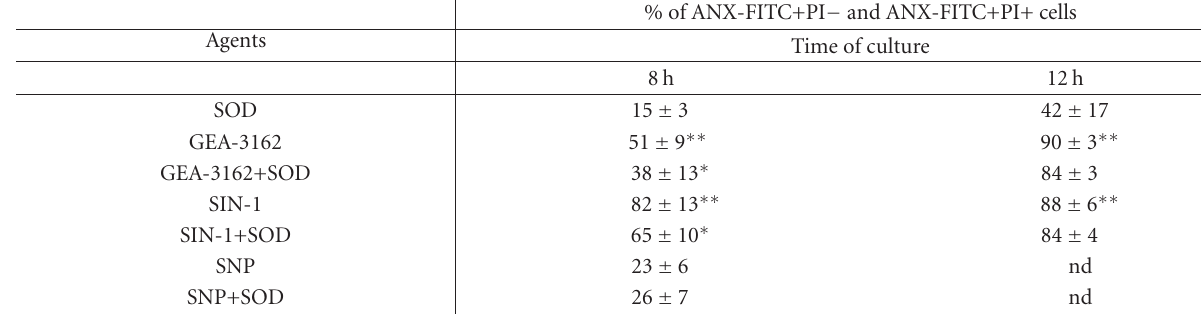
Table 1. Comparative analysis of apoptosis evaluated by ANX-FITC binding and cellular DNA content in the same sample of neu- trophil culture. Neutrophils (1 × 10 6 cells) were incubated with the indicated stimuli for 8 and 12 hours and apoptosis was determined as described in “materials and methods.” Results are given as means and SD percentages of apoptotic cells for 6 separate experiments. Statistical significance: neutrophils versus neutrophils with NO donors ( ∗ denotes that P ≤ . 05; ∗∗ denotes that P = . 027). % of ANX-FITC+PI − and ANX-FITC+PI+ cells % of cells with apoptotic nuclei Agents Time of neutrophils culture 8 h 12h Medium 28 ± 8 GEA-3162 SIN-1